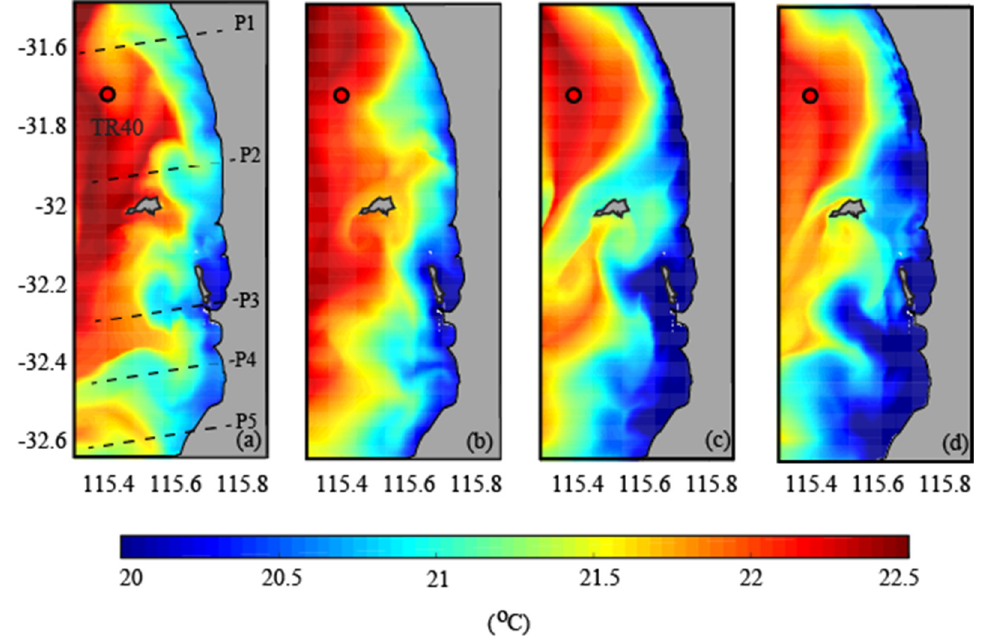
Figure 12. As for Figure 8 but during strong wind conditions (20 ms − 1 ): ( a ) May 20, 2016; ( b ) May 21, 2016; ( c ) May 22, 2016; and ( d ) May 23, 2016.